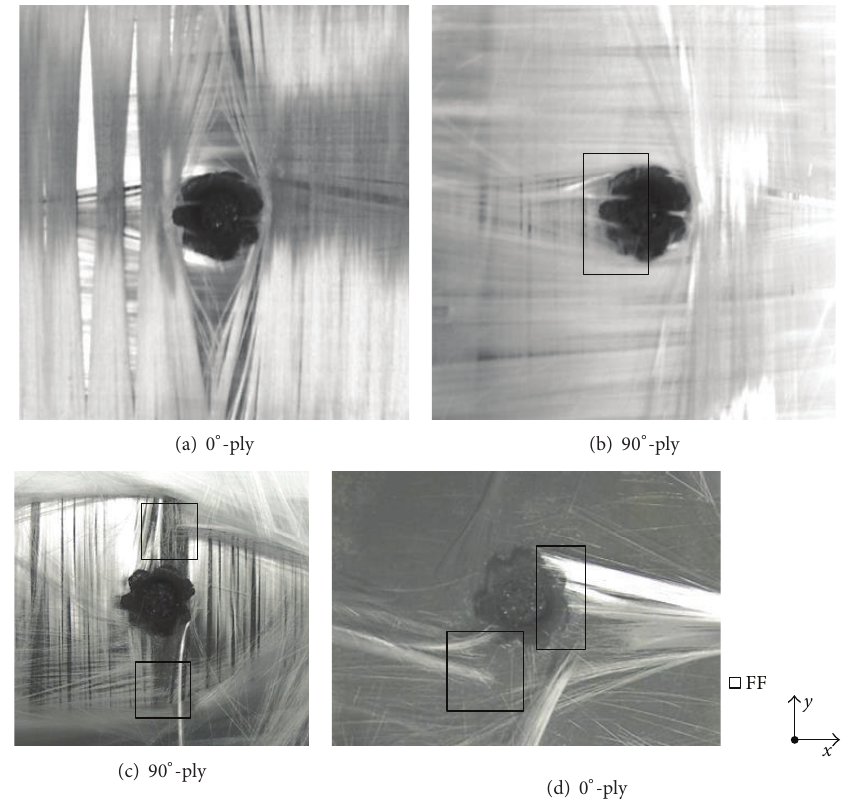
Figure 17: Analyzing the fiber orientation of DC04/GFRP joints by